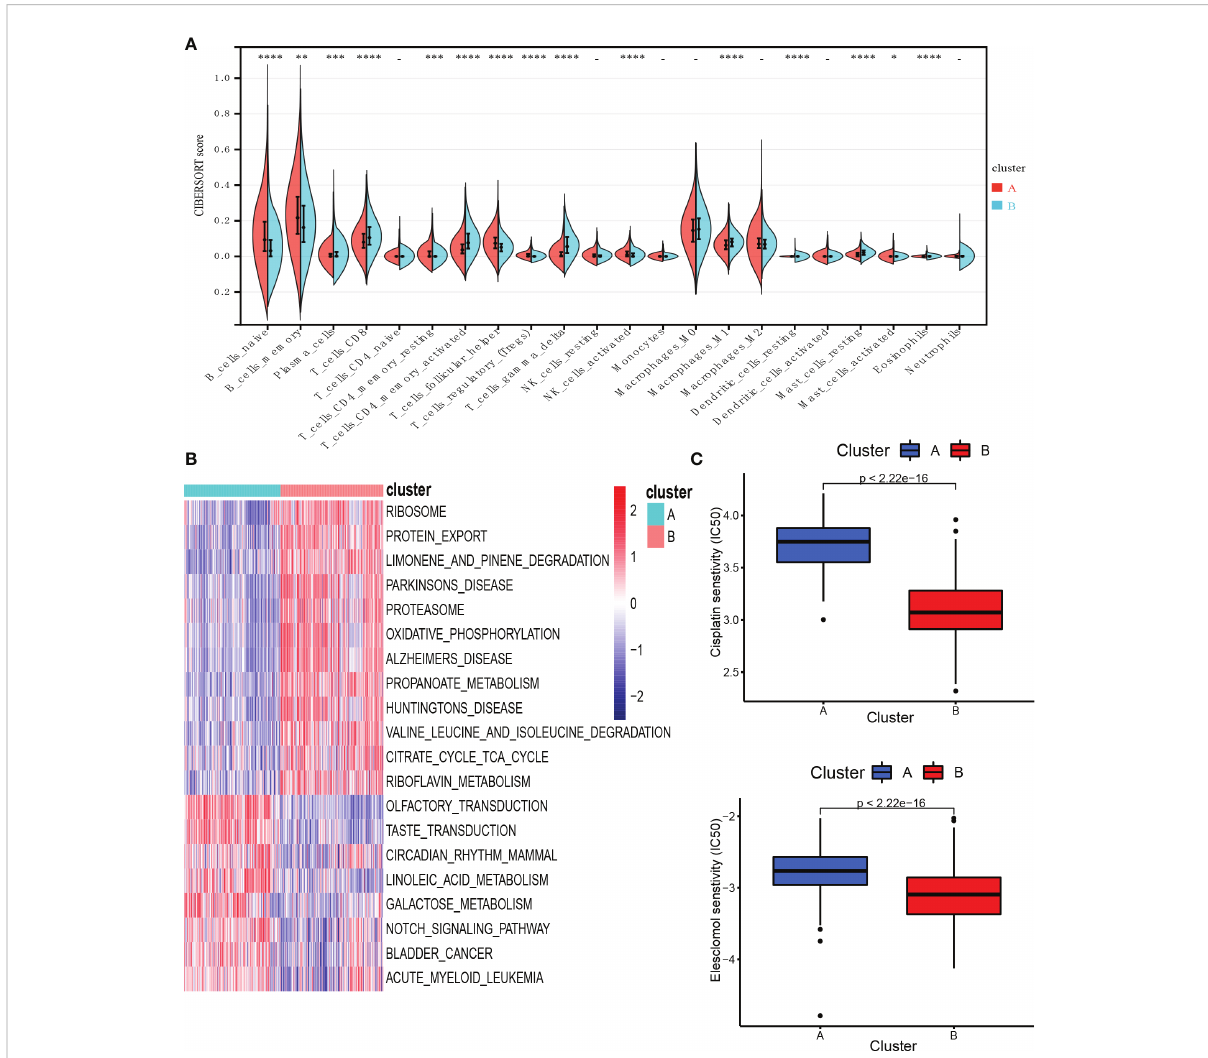
FIGURE 3 Characteristics of TME and biological function in the cuproptosis subtypes. (A) The abundance of different in fi ltrating immune cells in the two clusters. (B) GSVA of biological pathways between two distinct subtypes. (C) Prediction of drug responsiveness in the subtypes. * P < 0.05, ** P < 0.01, *** P < 0.001, **** P < 0.0001, - P > 0.05. TME, tumor microenvironment; IC50, half maximal inhibitory